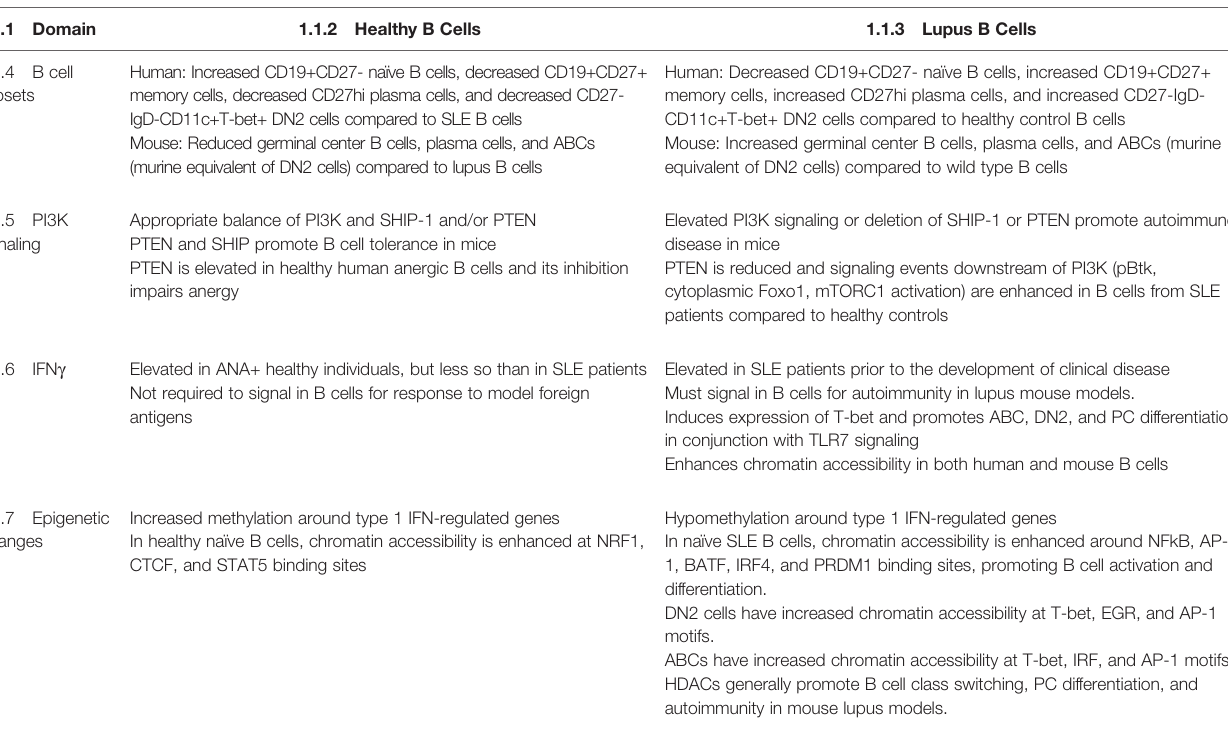
TABLE 1 | Differences between healthy and lupus B cells discussed in this